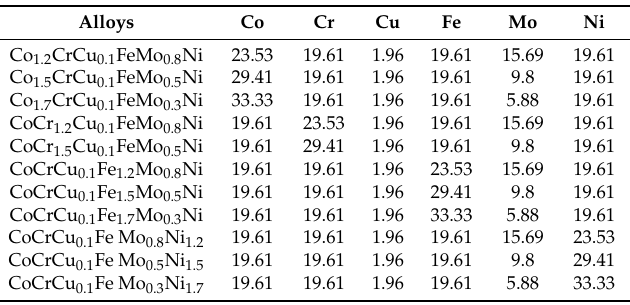
Table 1. A list of chemical composition of CoCrCu 0.1 FeMoNi-based alloys (at %).